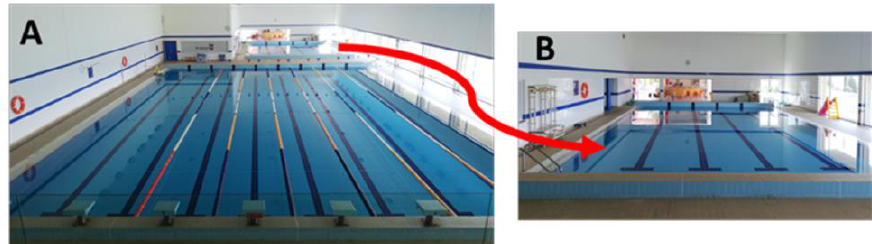
Figure 1. General view of the competition ( A ) and learning ( B ) pools. Table 1. Swimming- pool’s characteristics and mean values of some water parameters (Source: Bragança Municipality).